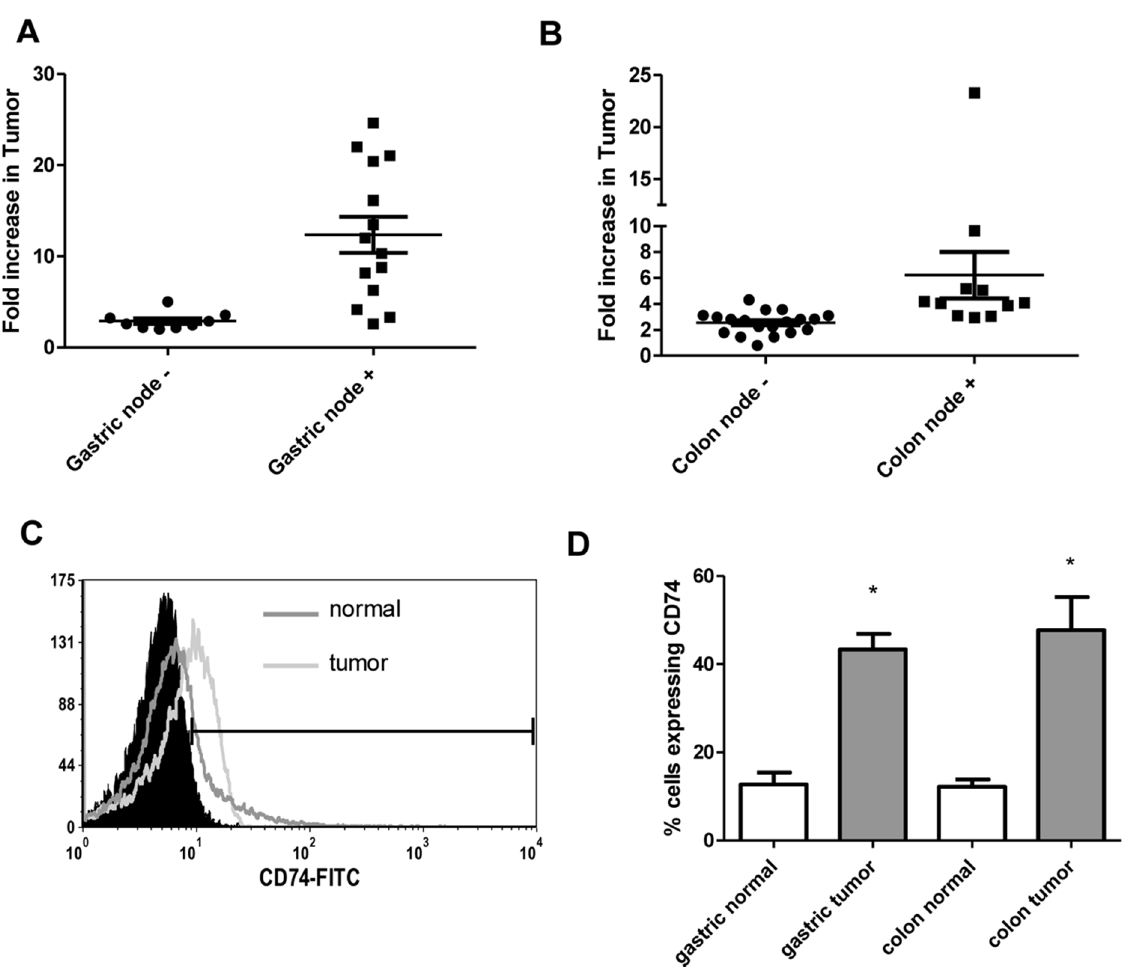
Figure 2. CD74 is highly expressed in human gastric and colon tumors and on isolated epithelial cells. CD74 mRNA levels measured by qRT PCR are increased in A) human gastric tumor samples and at higher levels in tissues from patients with nodal involvement, B) human colon tumor samples and at higher levels in tissues from patients with nodal involvement, and on epithelial cells isolated from human gastric and colon tumors in C) a representative flow cytometry plot and D) in compiled flow cytometry data from all samples. N=8 for D and the mean 6 standard error are shown as the results of duplicated in multiple experiments. * p , 0.05.